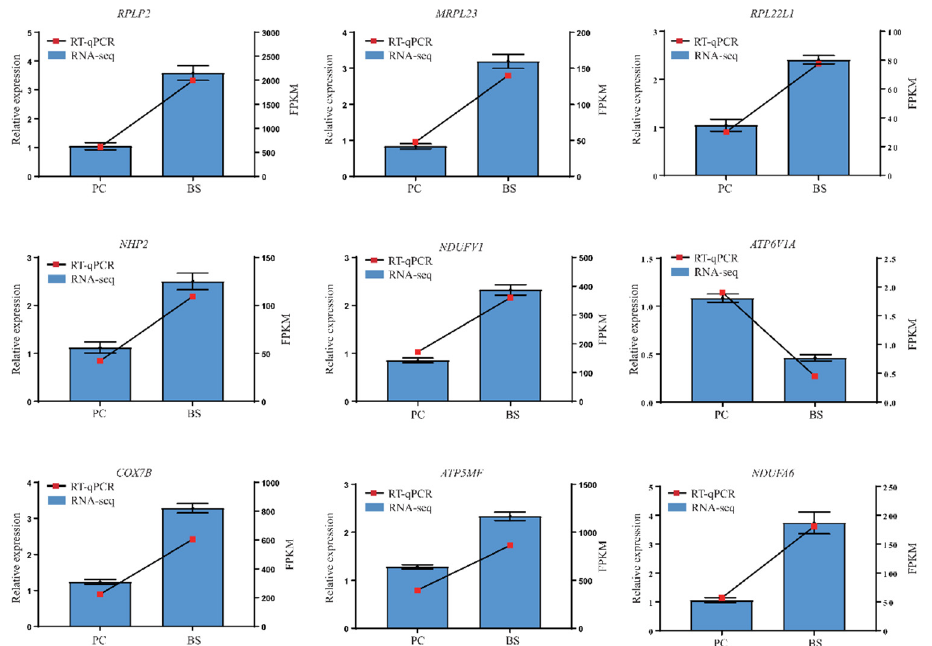
Figure 7. Relative expression levels from RT-qPCR. PC–positive group, basal diet with E. coli challenge. BS–basal diet + 2.5 × 10 9 CFU/kg B. subtilis with E. coli challenge. The relative expression values were normalized to the β -actin gene. RPLP2 : Ribosomal protein lateral stalk subunit P2; MRPL23 : Mitochondrial ribosomal protein L23; NHP2 : NHP2 ribonucleoprotein; NDUFV1 :